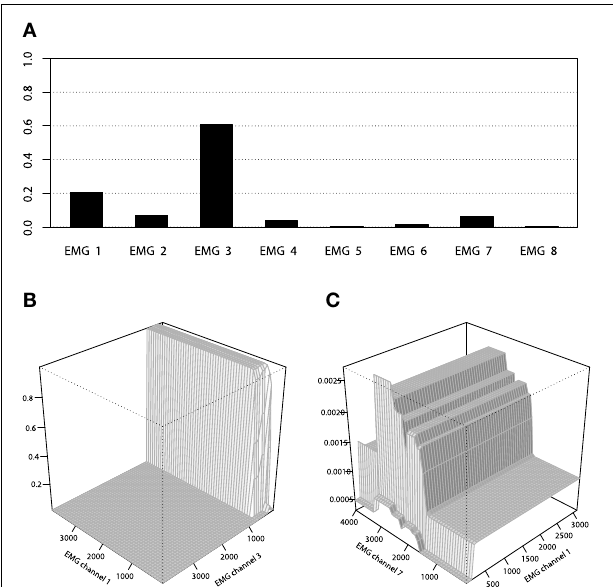
FIGURE 14 | (A) Relative variable influence of the EMG activity classifier for Bowing class. (B) Interaction plot of the EMG activity classifier for Bowing